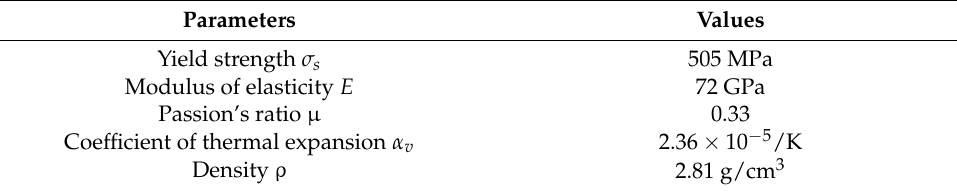
Table 2. Material properties of the pressure hull.